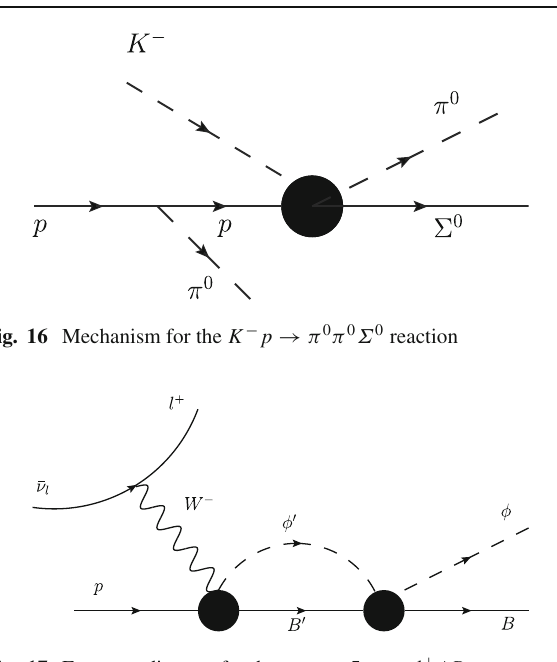
the Λ( 1405 ) is excited in spite of using kaon beams with K − p (initial) above threshold.